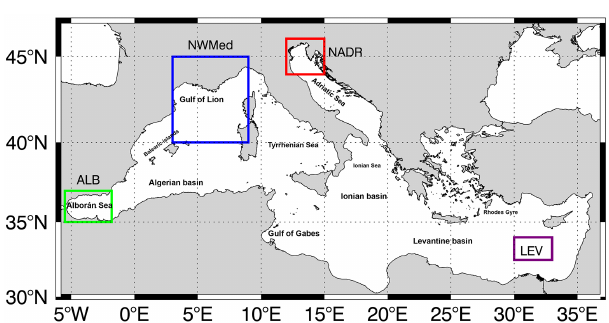
Figure 1. Maps of the Mediterranean Sea and its most interest- ing basins or sub-basins. The box indicates the region analysed in Sect. 6 for the seasonal and inter-annual variability of TChl a and PSCs at local scales. The green box refers to the Alborán Sea (ALB), the blue box to the Northwestern Mediterranean Sea (NWMed), the red one indicates the North Adriatic Sea (NADR) and the purple box refers to the Levantine Sea